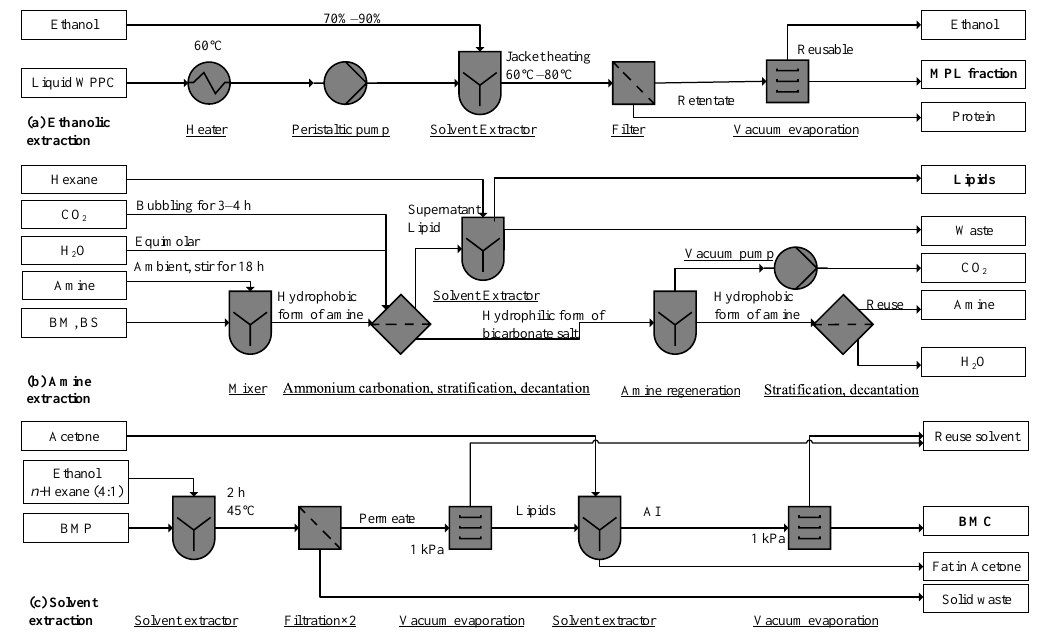
Figure 2. Process flow diagram of solvent extraction unit: ( a ) adapted from Price et al. [48], ( b ) Ota et al. [93], and ( c ) Shulman et al. [21]. BMC, buttermilk concentrate; MPL, milk phospholipid; AI, acetone